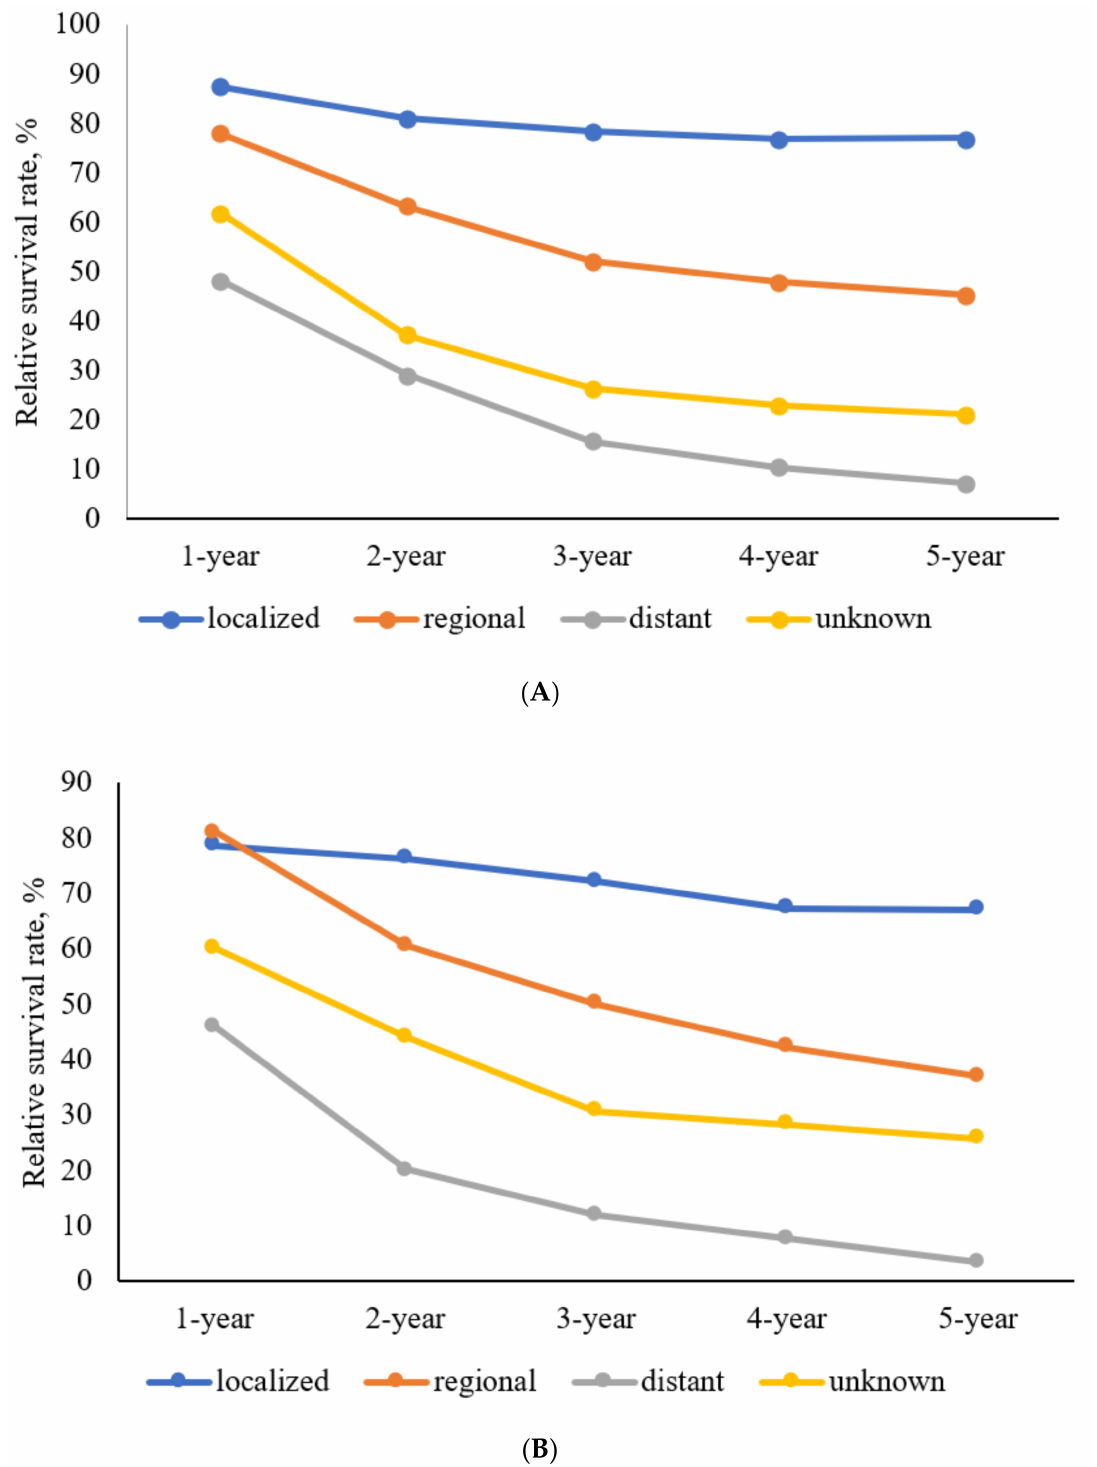
Figure 3. Relative survival rate of patients with colorectum signet-ring cell carcinoma between 1993 and 2017. ( A ) Relative survival rate of patients with colon signet-ring cell carcinoma between 1993 and 2017. ( B ) Relative survival rate of patients with rectum signet-ring cell carcinoma between 1993 and